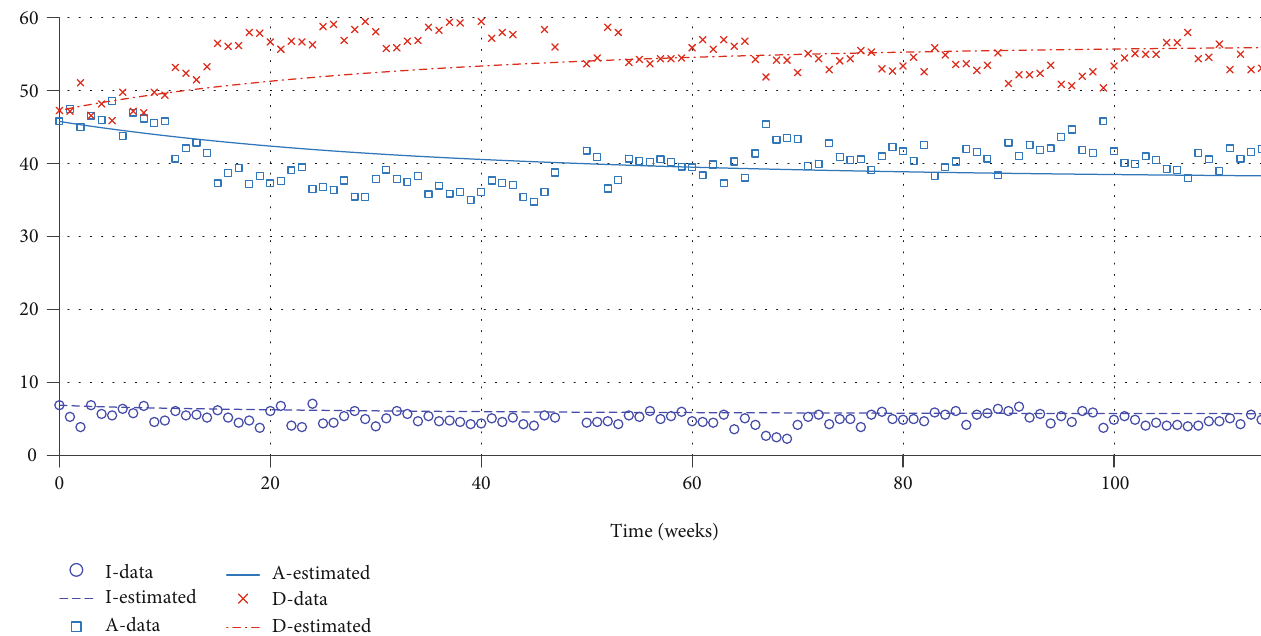
Figure 7: Three states of models (1)-(3) simulated with estimated parameter values from Table 5 and the real data of the second